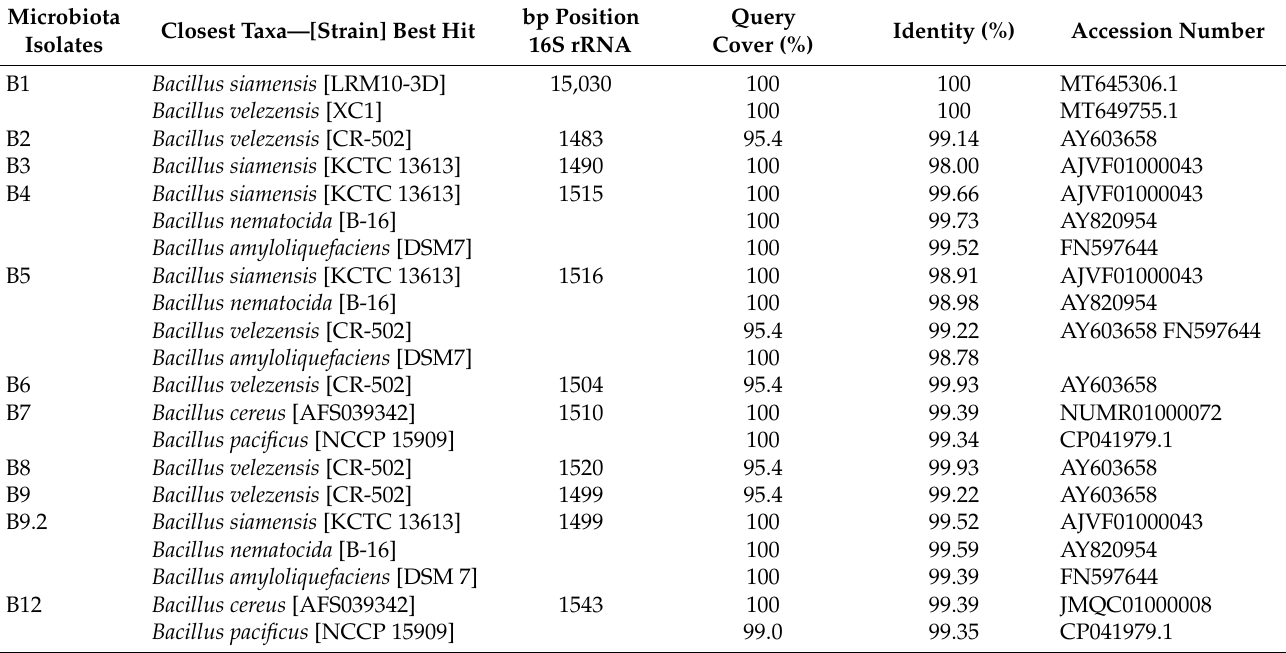
Table 2. Bacillus isolates from human microbiota and 16S rRNA complete gene homology description. Microbiota